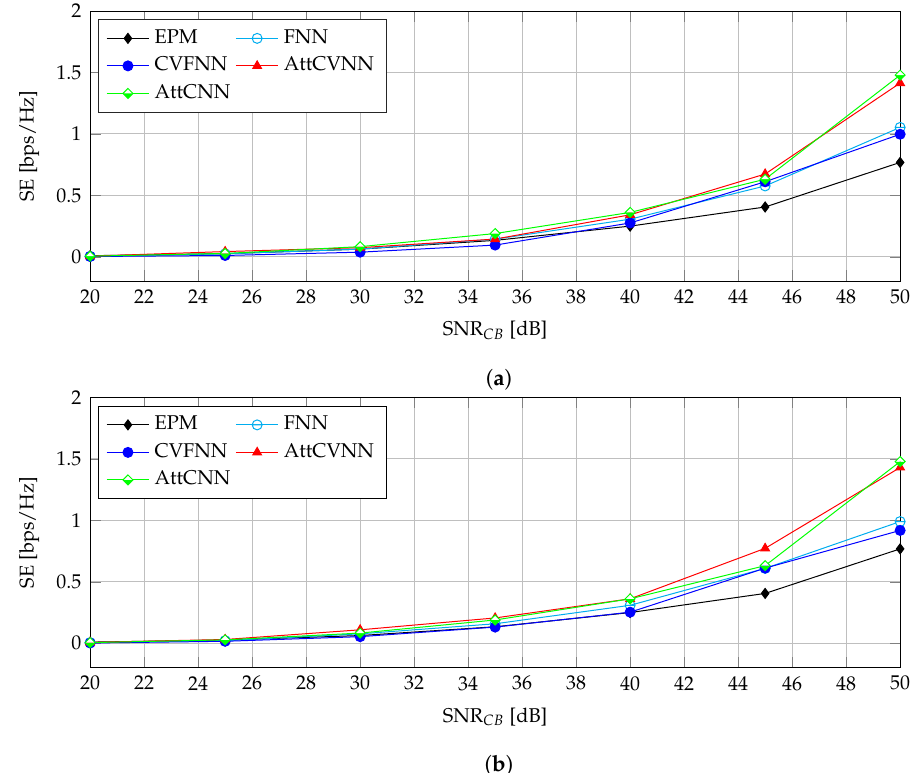
Figure 6. SE versus SNR CR for the configuration SNR PB = 60 dB: ( a ) INR = 20 dB; ( b ) INR = 30